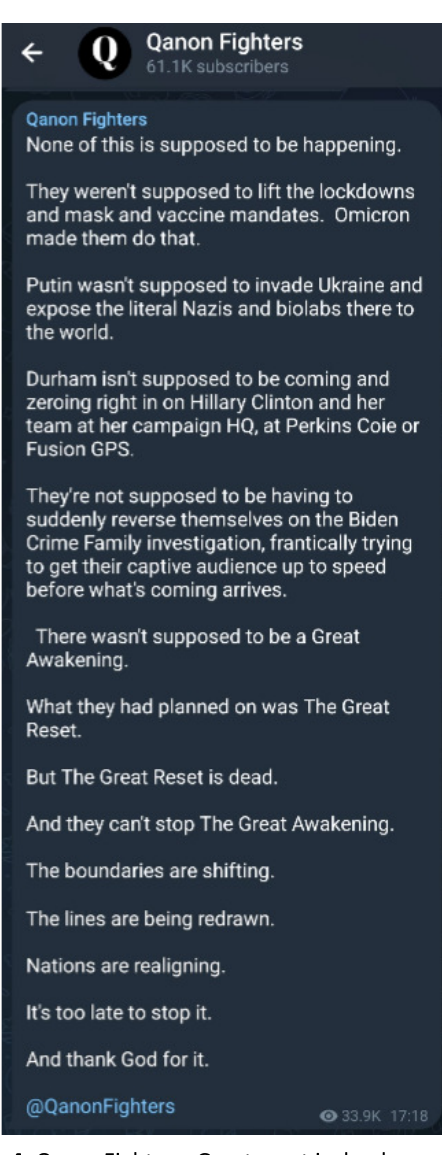
Figure 4. QanonFighters: Great reset is